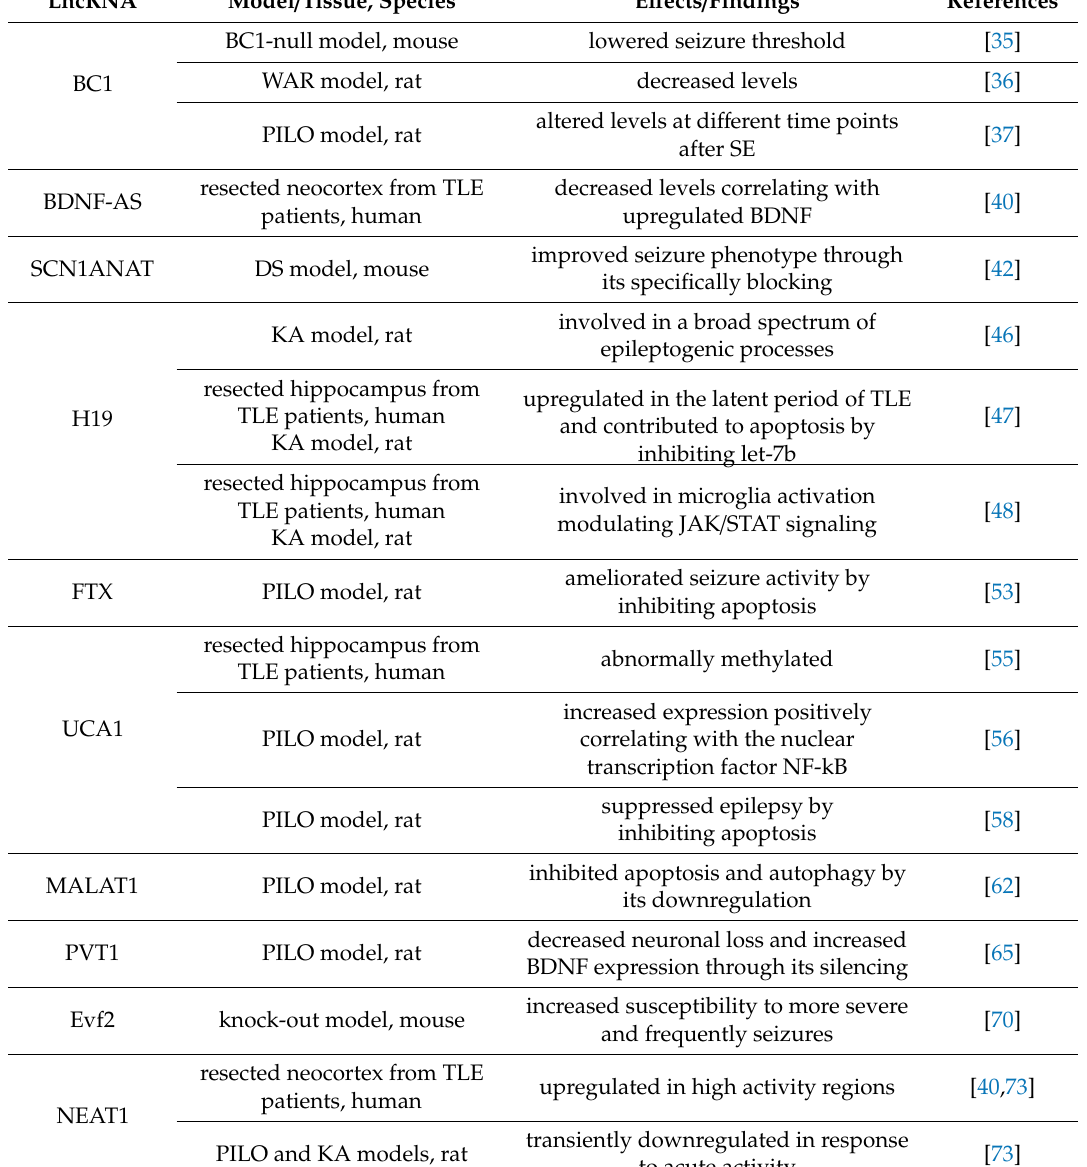
Table 1. Epilepsy-associated lncRNAs in